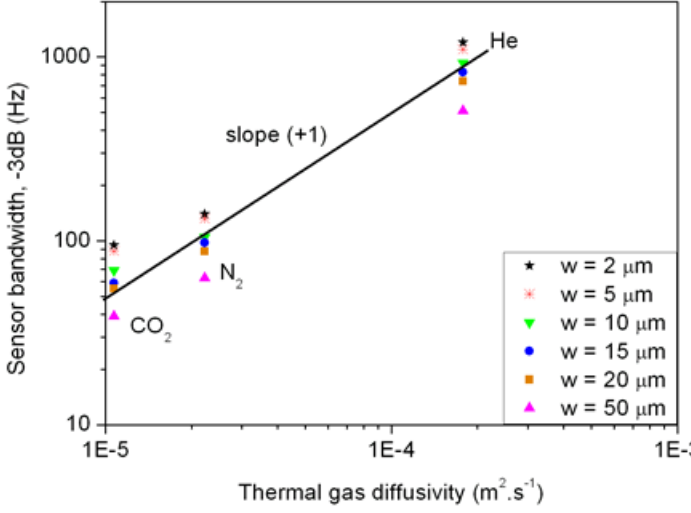
Figure 5. Sensor bandwidth at −3 dB vs. thermal gas diffusivity, for different detector